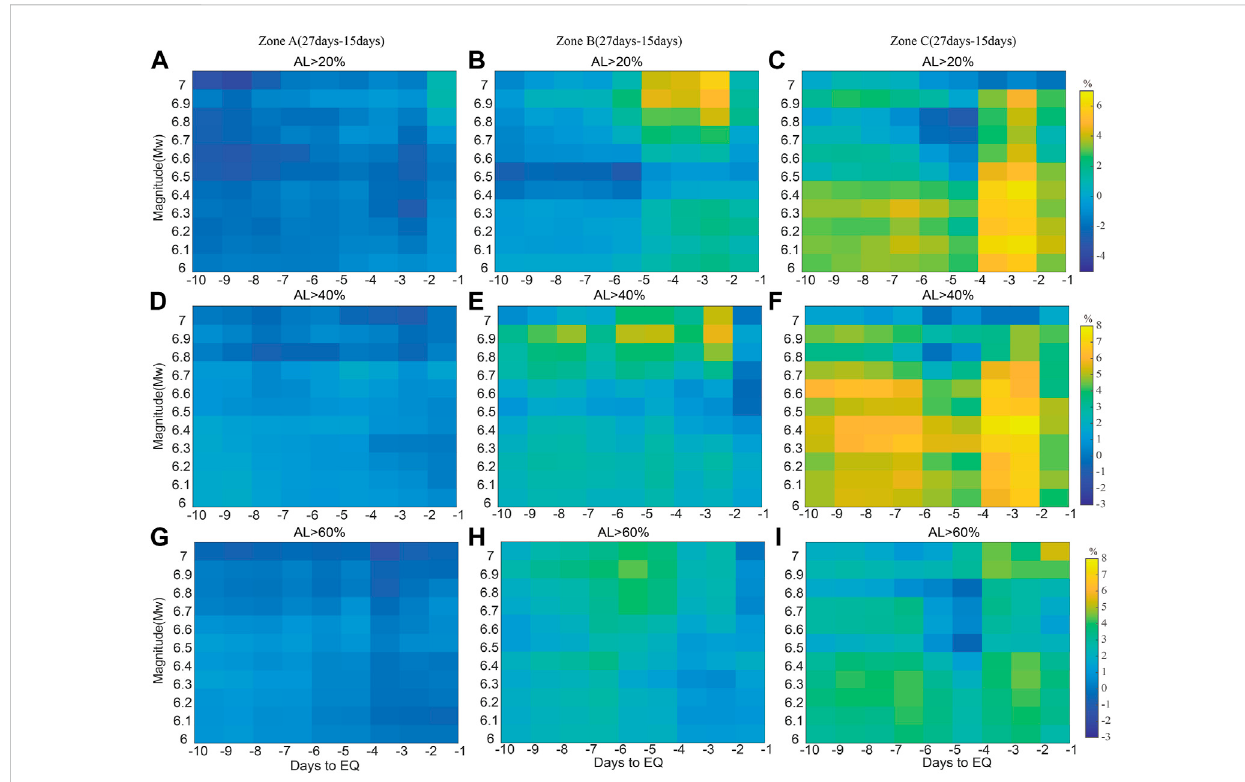
FIGURE 9 The differences of seismo-ionospheric anomalies occurrence rates between the results of 27-day and 15-day sliding windows. (A, D, G) represent the results in Zone A. (B, E, H) represent the results in Zone B. (C, F, I) represent the results in Zone C.